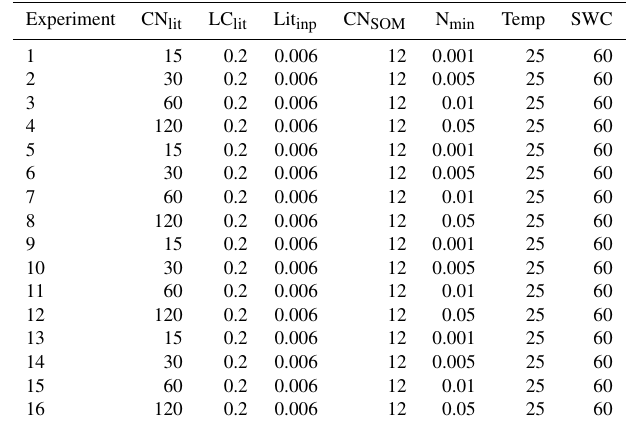
Table A4. Specific setting of litter and SOM properties, and soil conditions in the 16 idealized simulations for exploring the impacts of litter stoichiometry (i.e., C:N ratio) and soil mineral N on SOC accumulation. CN lit and LC lit are the C:N ratio and lignin-to-C ratio of plant litter, respectively. Lit inp (gCkg − 1 soilday − 1 ) is the daily input rate of plant litter. CN SOM is the C:N ratio of SOM pool. N min − N + NH + − N). Temp ( ◦ C) and SWC (%) are the temperature and soil water (gNkg − 1 soil) is the concentration of soil mineral N (NO − 3 4 content,